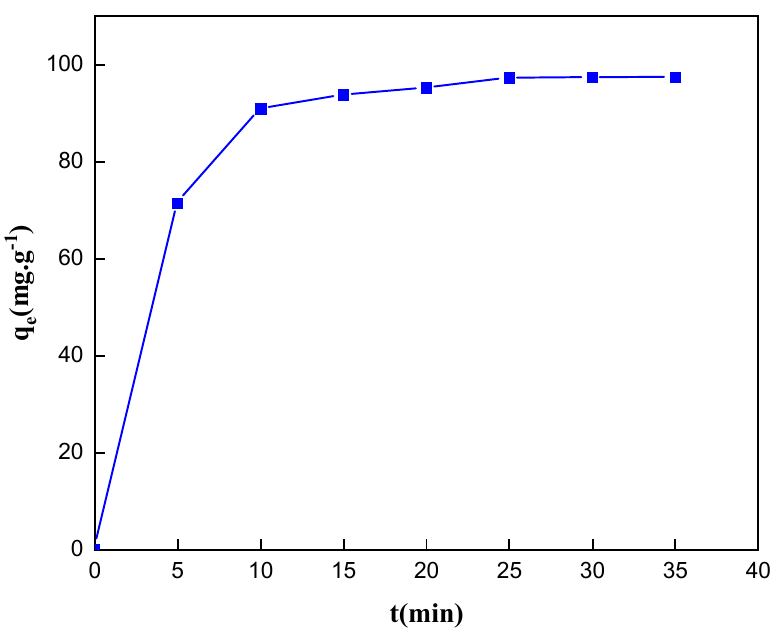
Figure 6. Effect of contact time on the adsorption capacity of Cu(II). Adsorption conditions: V = 10 mL, m = 10 mg of adsorbent, pH = 6, and optimum concentrations: 150 mg L − 1 for Cu(II) at 25 °C.